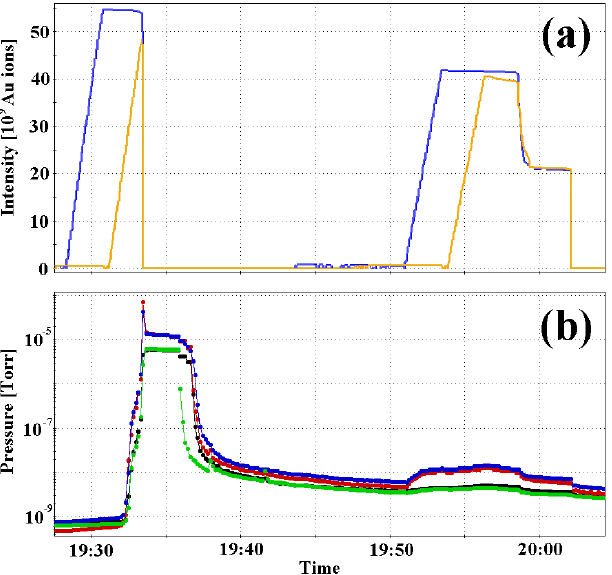
FIG. 1. (Color) The first two attempts to fill both rings with 110 bunches, twice the design number (October 2001) [14]. Intensities of the two RHIC rings, named Blue and Yellow are shown in part (a) and the pressure measured at four gauges in an interaction region is shown in part